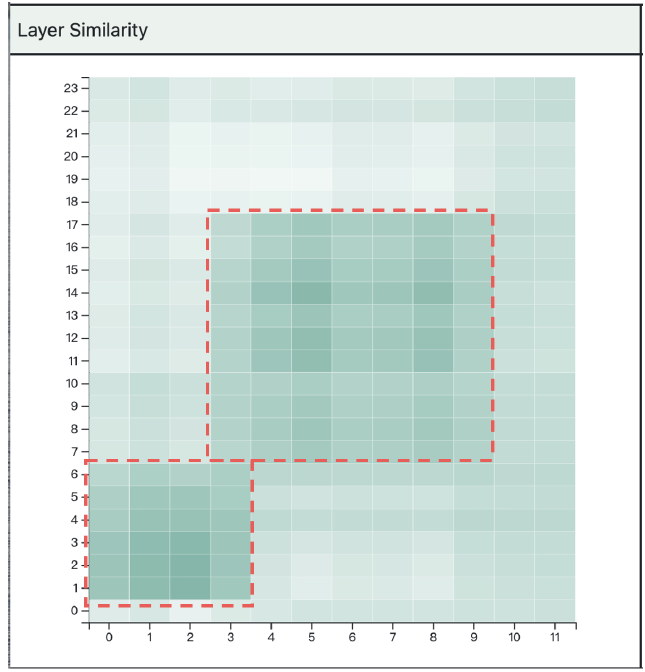
Figure 6. Layer similarity graph. The graph summarizes similarity values for all layer combinations between the two models. Users can find layer combinations worth for exploring by observing patterns in this graph. x-axis and y-axis represent the one layer from each compared model. These two models have twelve and twenty-four